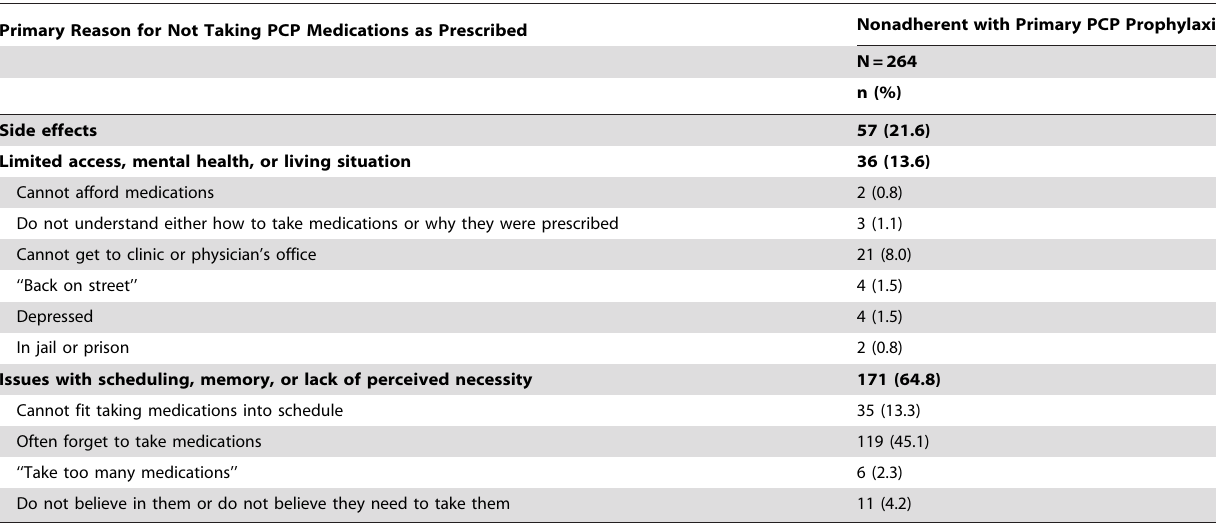
Table 3. Primary reason for not taking medications to prevent Pneumocystis jirovecii pneumonia (PCP) listed by 264 persons who were nonadherent with primary PCP prophylaxis – Supplement to HIV/AIDS Surveillance (SHAS) project, 2000–2004.